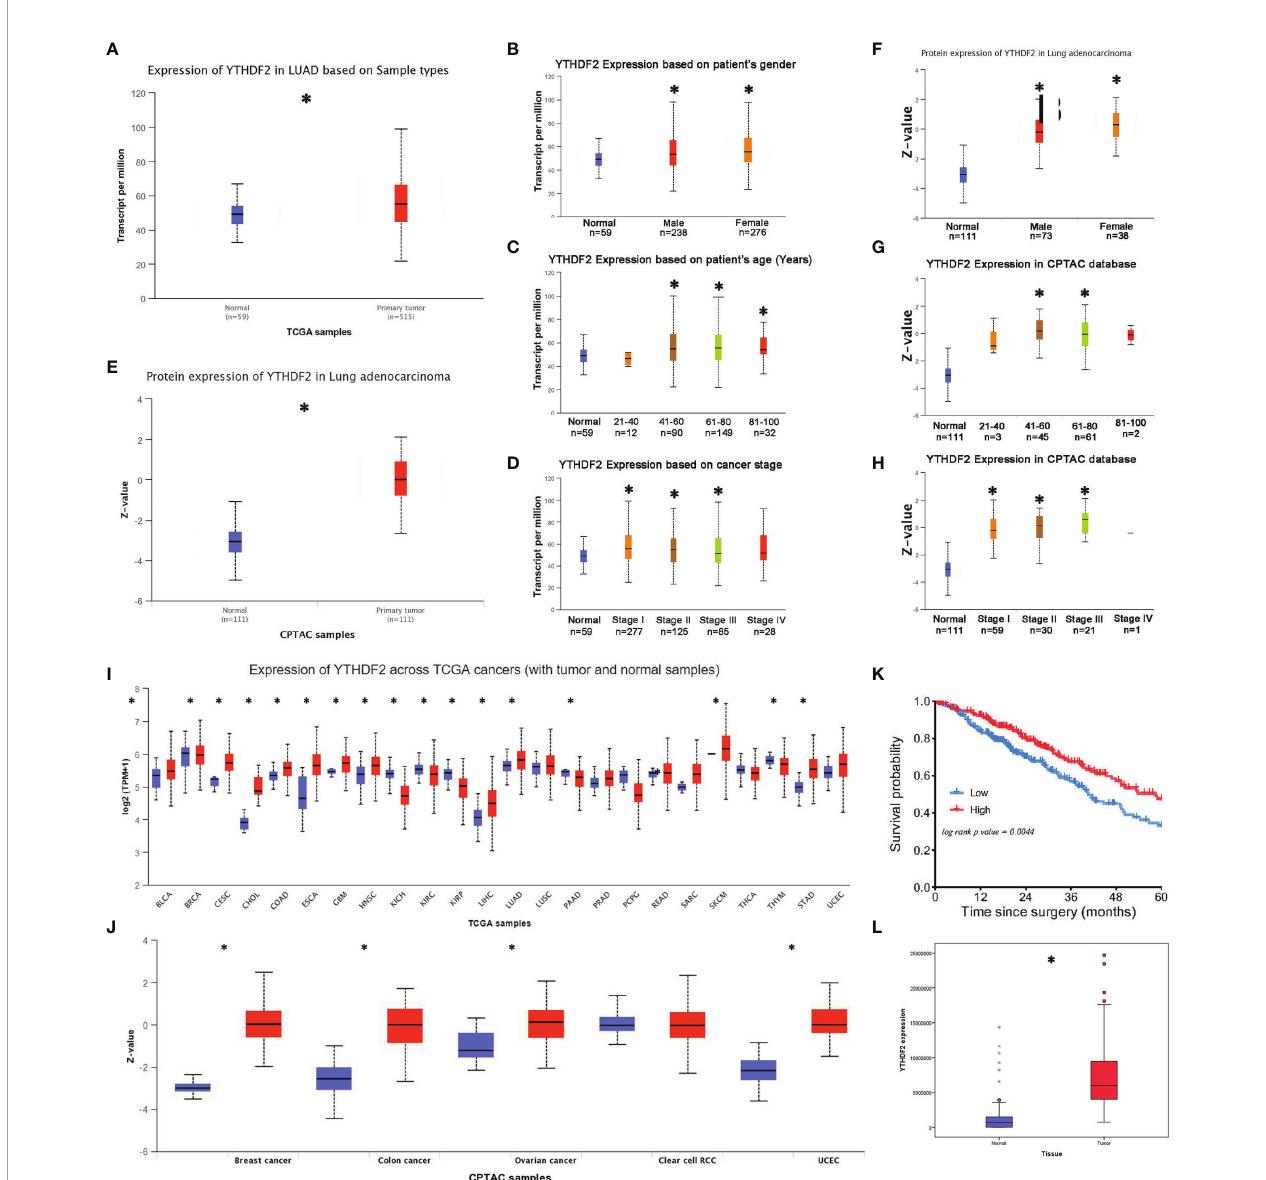
FIGURE 1 | YTHDF2 expression in lung adenocarcinoma. (A) YTHDF2 expression in lung adenocarcinoma tissues and normal tissues in TCGA database. (B – D) YTHDF2 expression in different patient subgroups compared with normal controls in TCGA cohort. (E) YTHDF2 expression in lung adenocarcinoma tissues and normal tissues in the CPTAC database. (F – H) YTHDF2 expression in different patient subgroups compared with normal controls in the CPTAC cohort. (I) Pancancer analysis of YTHDF2 expression in TCGA database. (J) Pancancer analysis of YTHDF2 in the CPTAC database. (K) Analysis of the OS of patients with lung adenocarcinoma in TCGA database. (L) YTHDF2 expression in lung adenocarcinoma tissues and normal tissues in the CNHPP database. *Statistical difference (P <